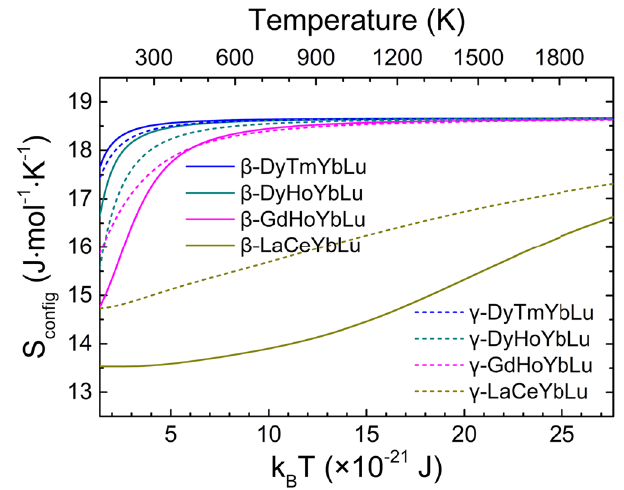
Fig. 6 | The con fi gurational entropy of mixing for the β -type and γ -type ensembles. The calculated con fi gurationalentropyof mixing ( S con fi g )asafunction of thermal-energy excitation ( k B T ) as well as the temperature ( T ) for each con fi g- uration